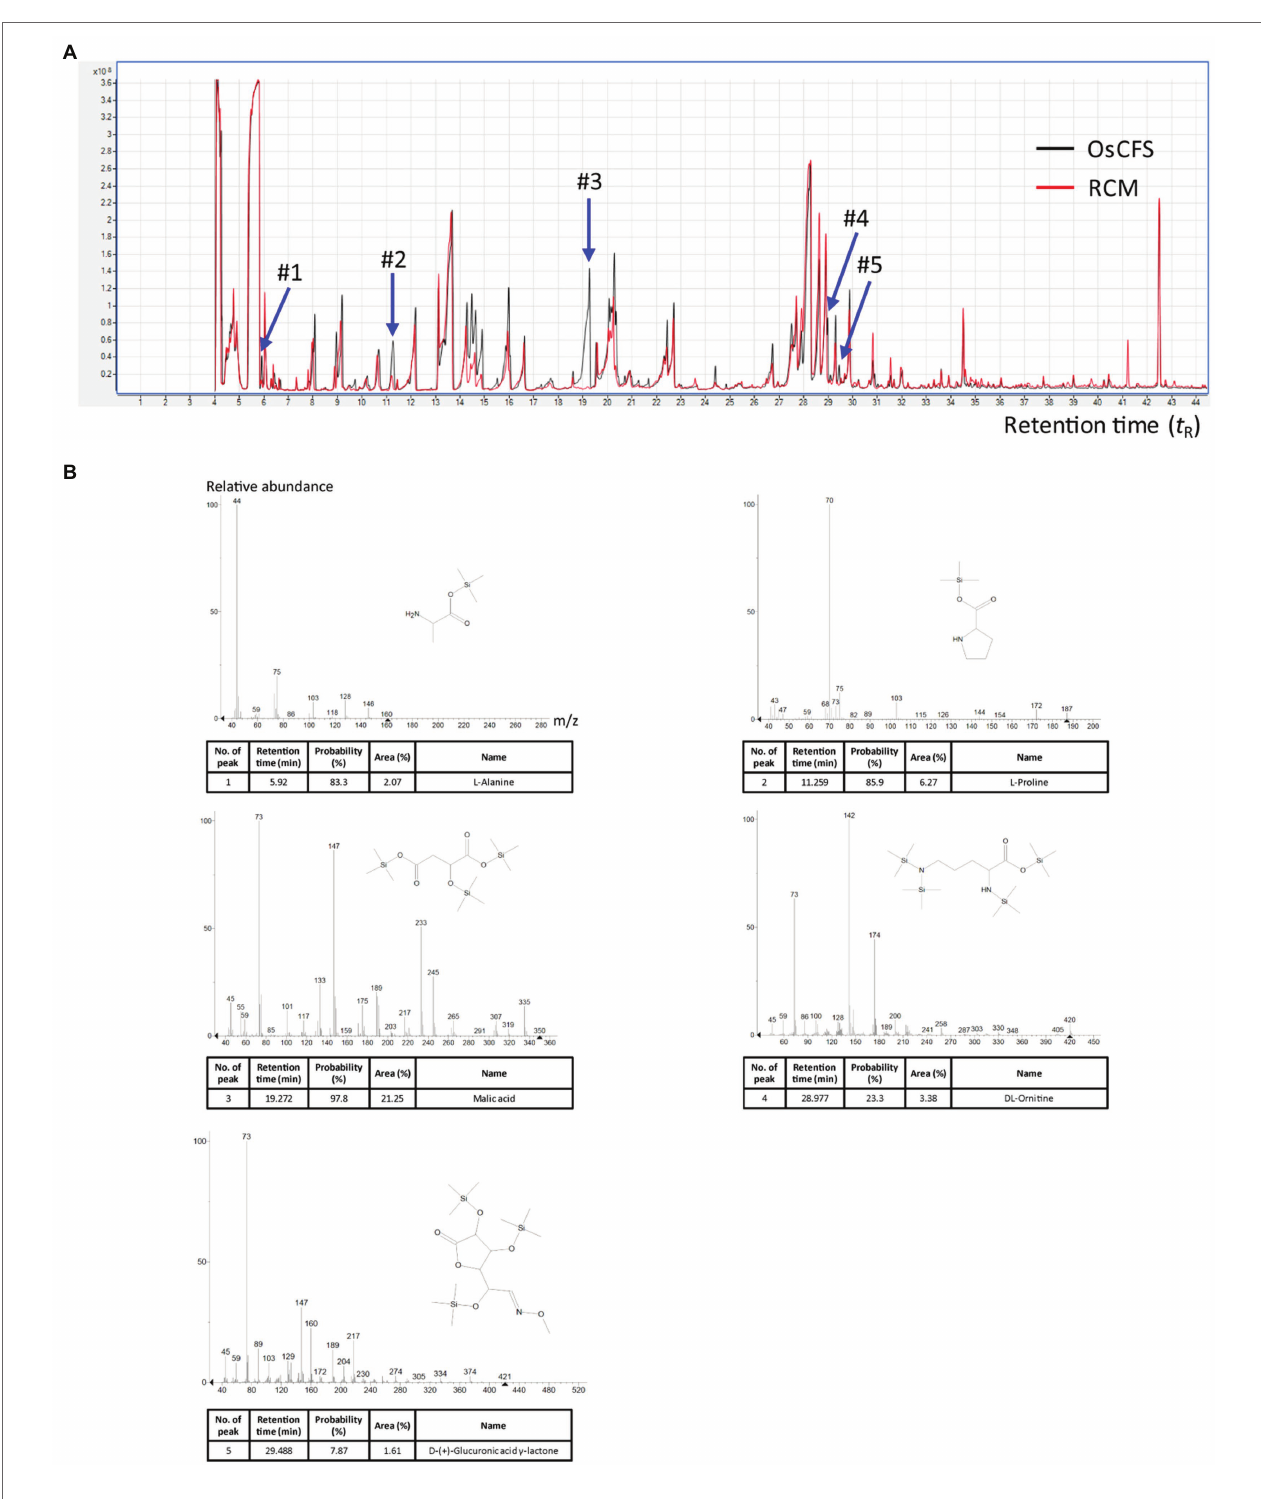
FIGURE 4 | Metabolomic analysis with gas chromatography–mass spectrometry (GC–MS) to identify potential metabolites. The total ion chromatograms (TICs) of the aqueous phase of the extract were obtained by GC–MS analysis. (A) The merged TICs of the aqueous phase of the extracts of RCM and Odoribacter splanchnicus cell-free supernatant (OsCFS). The red and black peaks, respectively, indicate a representative sample from the aqueous phase of the extract of OsCFS and RCM. (B) Mass spectra of putative compounds from differential peaks (#1-#5) matching against mass spectral libraries